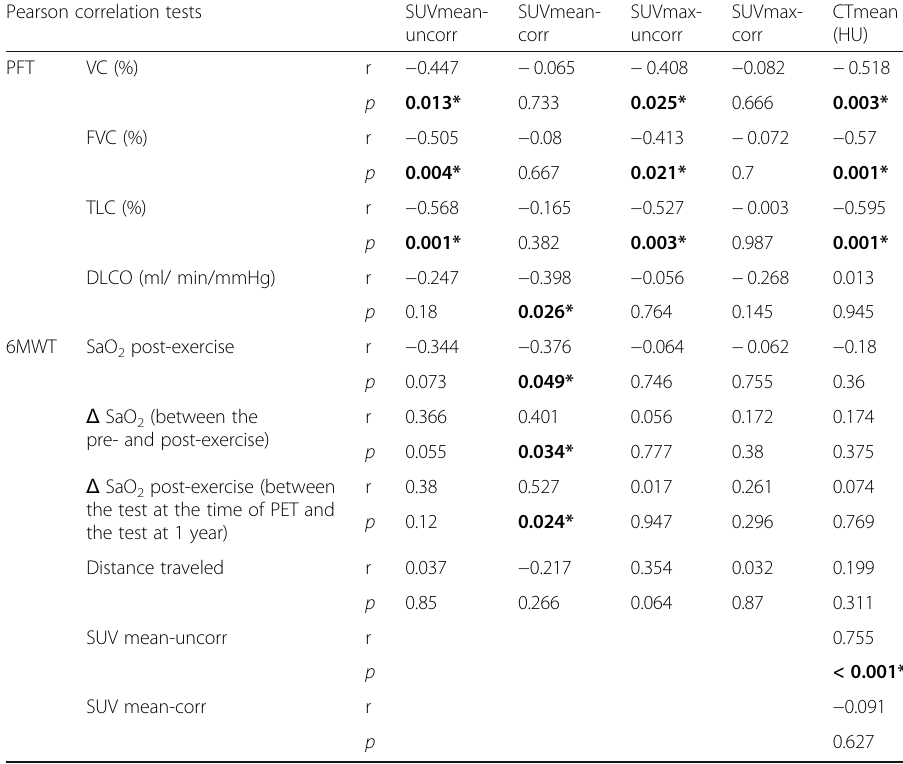
Table 2 Main correlations between PET/CT parameters and functional or exercise-related parameters Pearson correlation